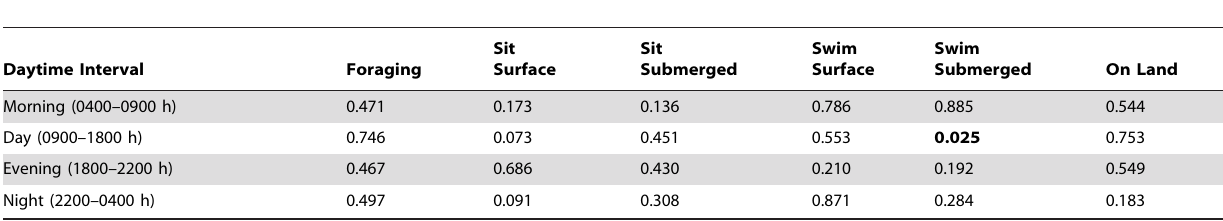
Table 4. Two sided P -values from random permutation test for independence of proportion spent performing activities from time of